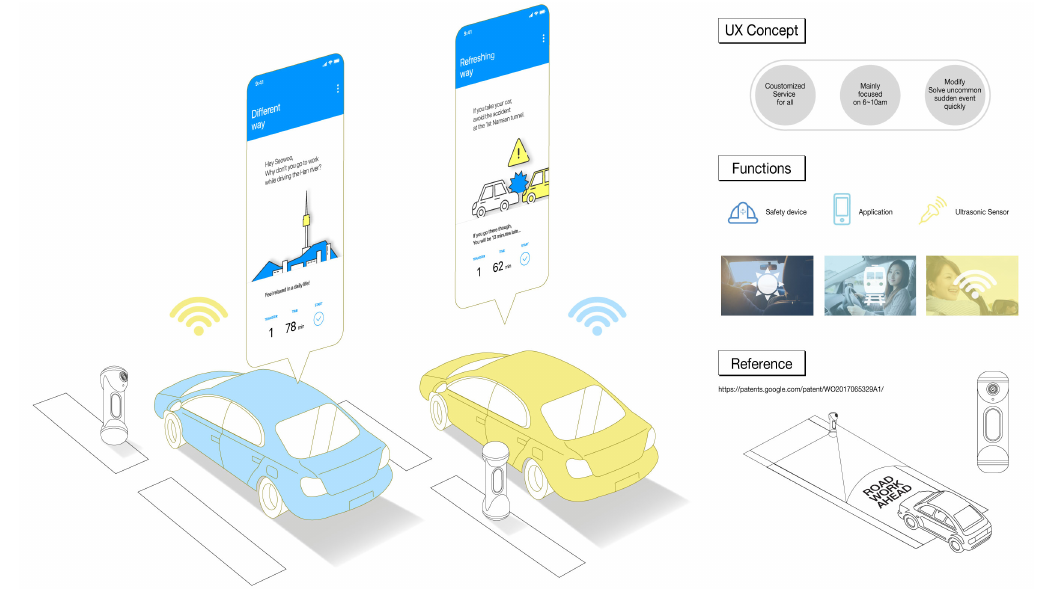
Figure 16. Convergence scenario from safety sensor robot to inform mobile application. Adapted from [6,29] including 3 user experience concepts and 3 functions converged into 3 mobile app services.